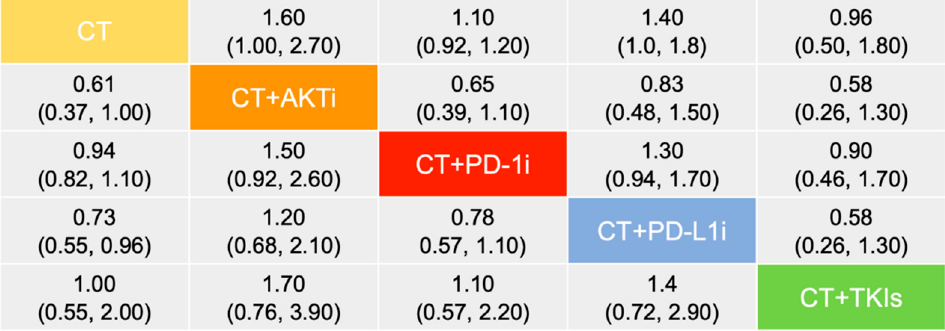
Figure 4. Comparative analysis of overall survival among adopted treatments. Data are presented as hazard ratio and 95% credible interval. The upper right values display the top treatment compared the bottom treatment. The lower left values demonstrate the converse comparisons. Abbreviation: AKTi, Protein kinase B inhibitor; CT, Chemotherapy; PD-1i, Programmed cell death protein 1 inhibitor; PD-L1i, Programmed cell death ligand 1 inhibitor; TKIs, Tyrosine kinase inhibitors.